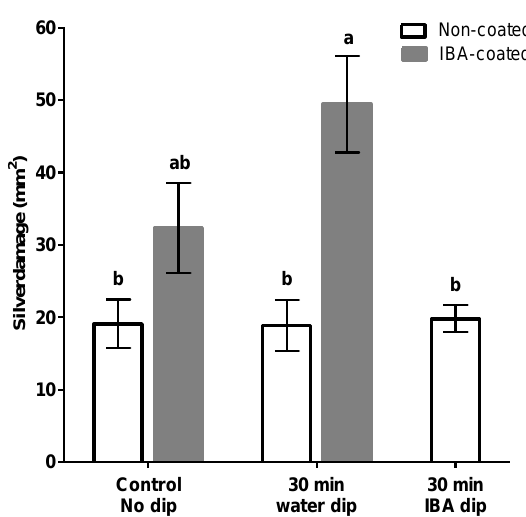
Figure 8. Effect of powder and liquid auxin formulations on silver damage. Unrooted IBA-coated (cv. Baltica) cuttings were dipped in water for 30 min. Non-coated cuttings were dipped in an equimolar concentration of 4000 ppm or water. Control cuttings did not receive a water dipping treatment. Bars (mean ± SEM, n = 13–15) represent the cumulative silver damage expressed as damaged leaf area in mm 2 . Different letters indicate significant differences among groups as determined by Kruskal–Wallis followed by Games–Howell multiple post hoc comparison ( p < 0.05).